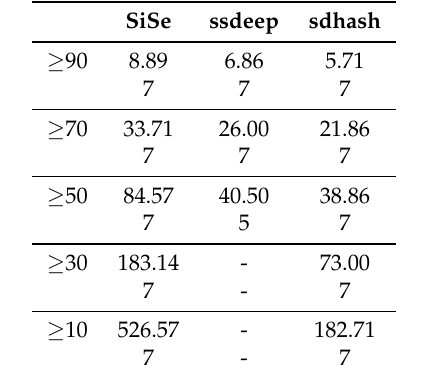
Table 31. Obfuscation resistance test showing the score (first value) and the number of matches (second value) when testing 7